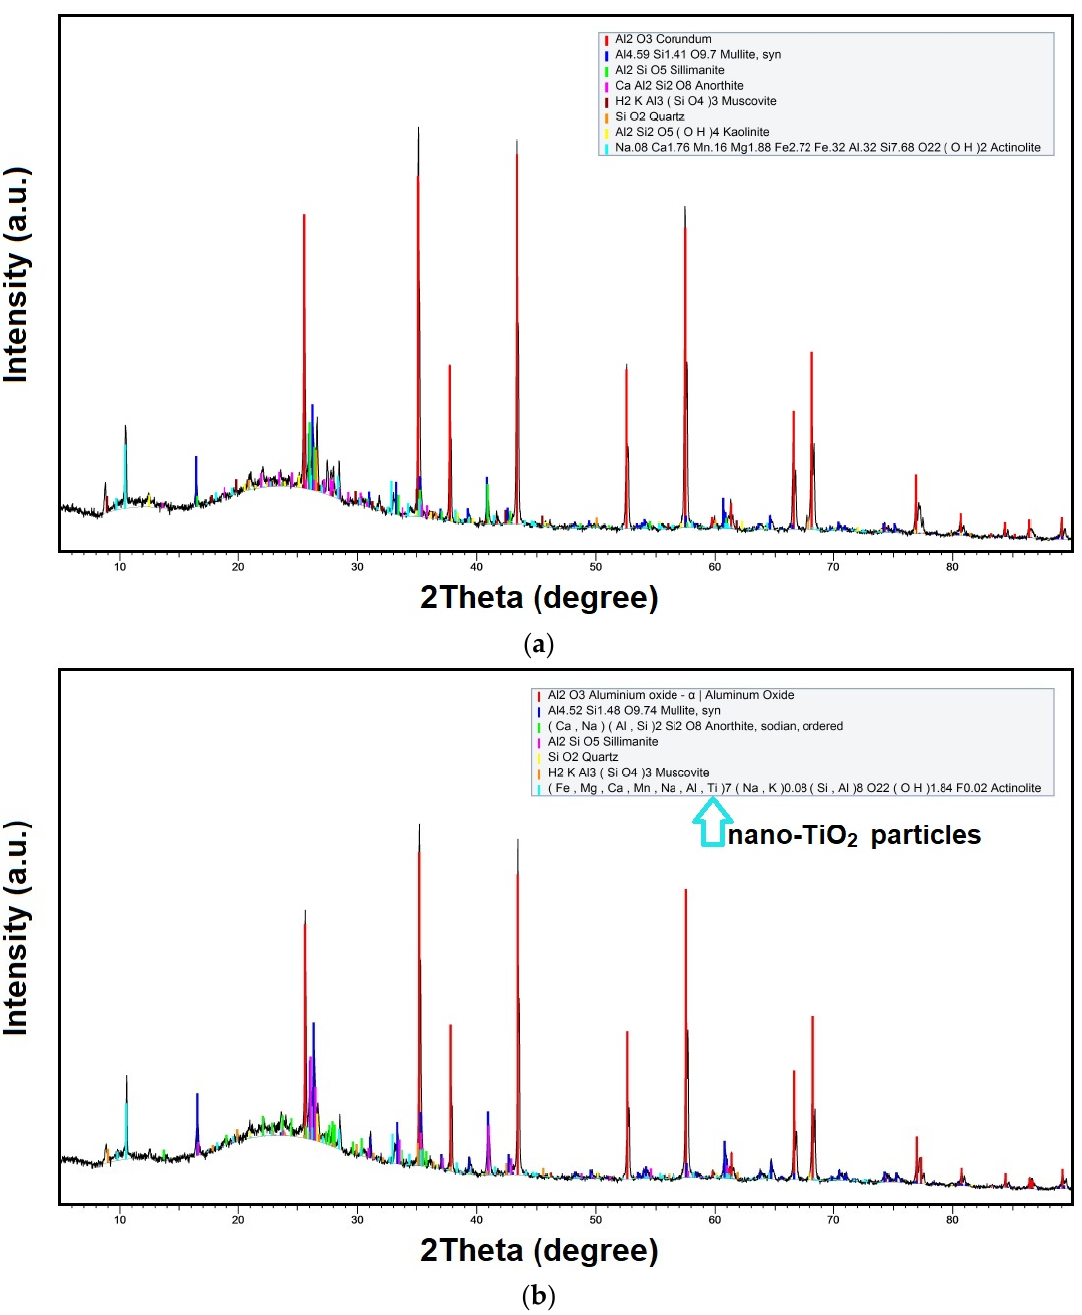
Figure 13. X-ray diffraction (X-RD) phase analysis. ( a ) X-RD pattern of a normal porcelain insulator prototype; ( b ) X-RD pattern of a nano-TiO 2 coated porcelain insulator prototype.